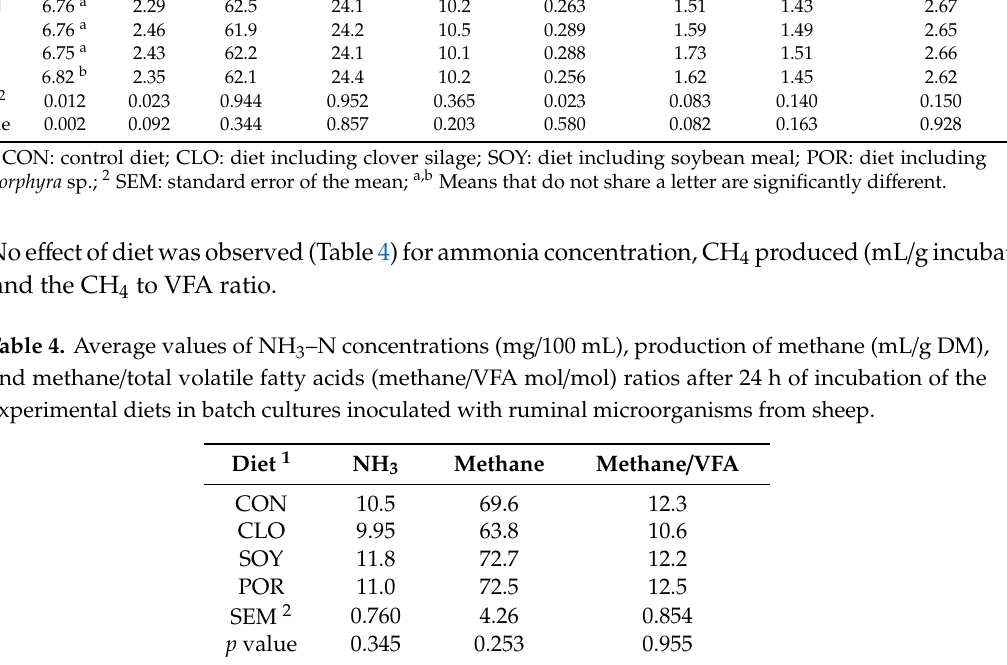
1 CON: control diet; CLO: diet including clover silage; SOY: diet including soybean meal; POR: diet including Porphyra sp.; 2 SEM: standard error of the